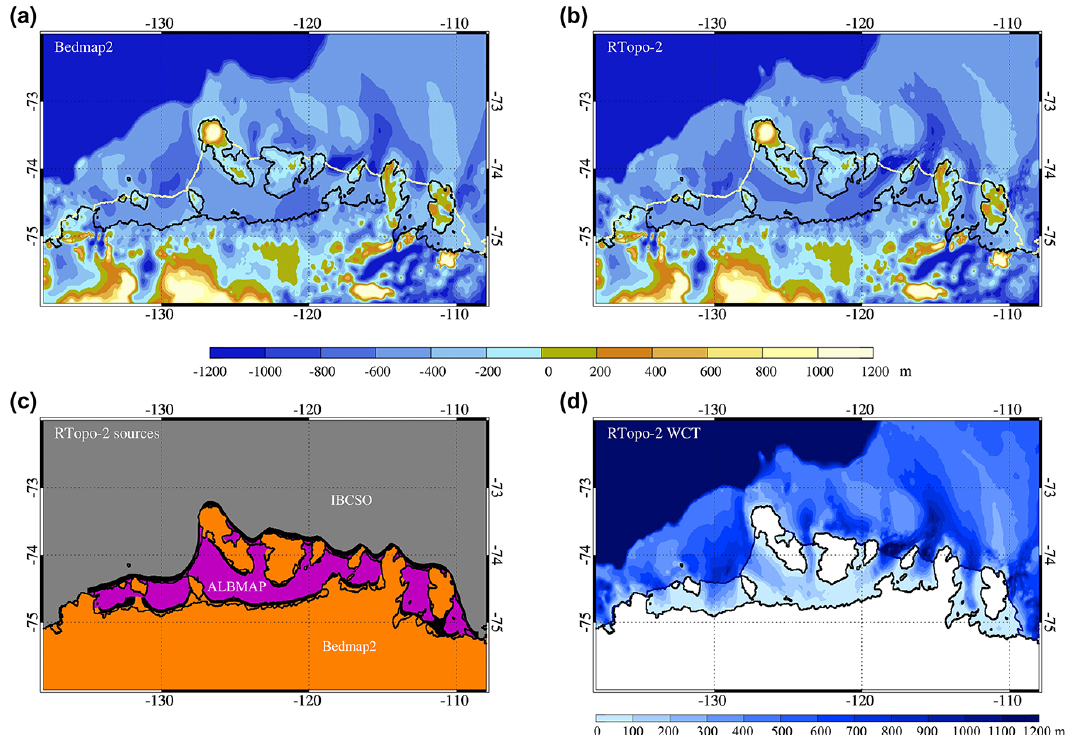
Figure 6. Bathymetry for Getz Ice Shelf cavity and its surrounding in Bedmap2 (a) and the merged bathymetry in RTopo-2 (b) . (c) Indication of data sources for the RTopo-2 bathymetry grid, with colours corresponding to the global source map in Fig. 2. (d) Water column thickness obtained from RTopo-2 ice shelf draft and